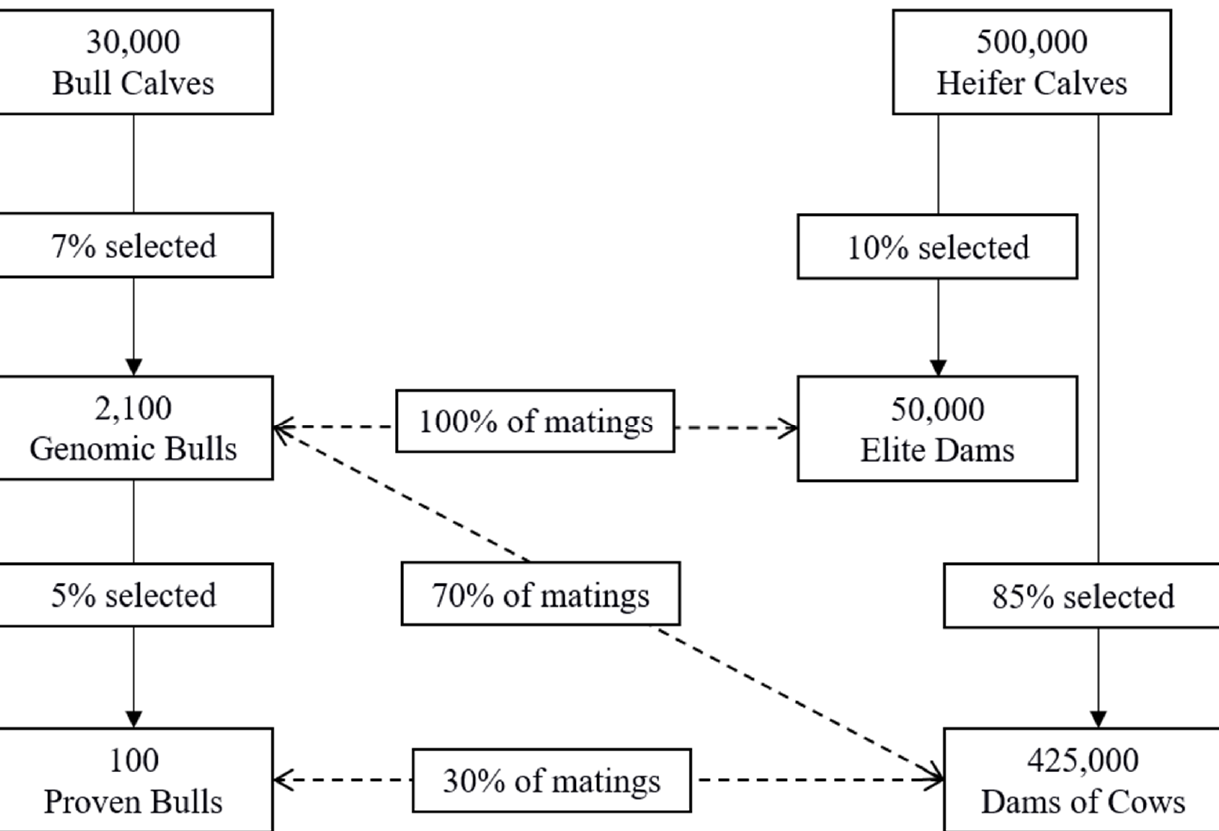
Figure 1. Diagram of the population breeding structure used in all scenarios.